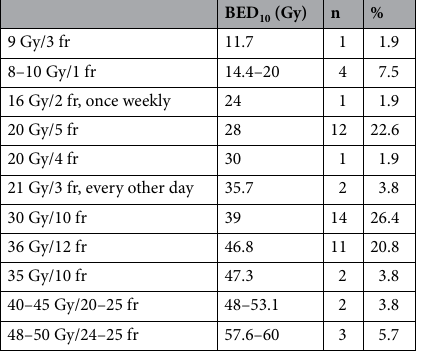
Table 2. Radiation dose and schedule. Three patients received concurrent intra-arterial chemotherapy with radiotherapy: one 50 Gy in 25 fractions with 5-fluorouracil, one 48 Gy in 24 fractions with cisplatin and pirarubicin, and one 30 Gy in 10 fractions with irinotecan hydrochloride hydrate. Abbreviations: fr fraction.